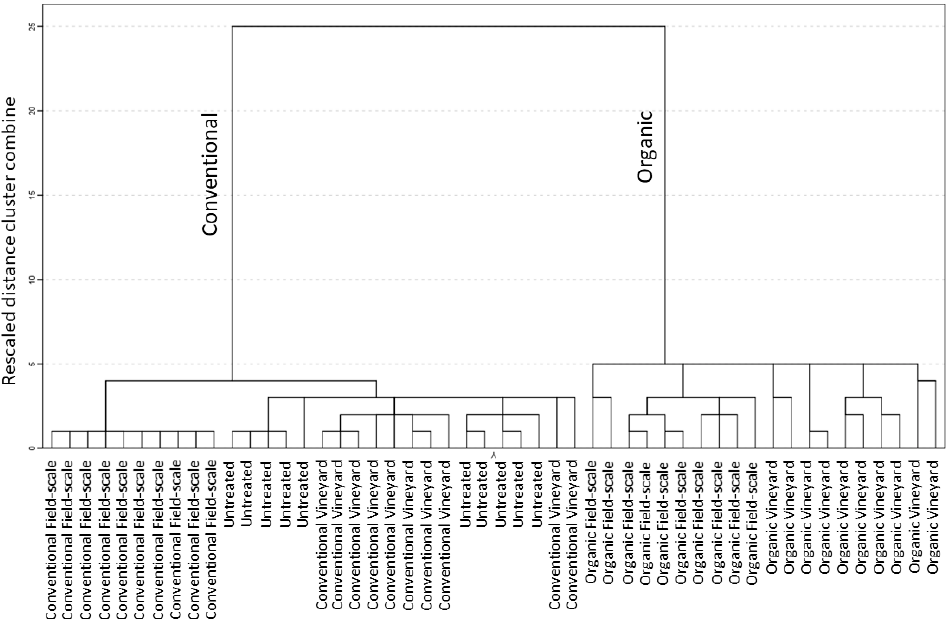
Figure 2. Dendrogram of the cluster analysis of main soil properties and DTPA extractable metals in the organic and conventional fertilized soils (vineyard, field-scale, and untreated = control).